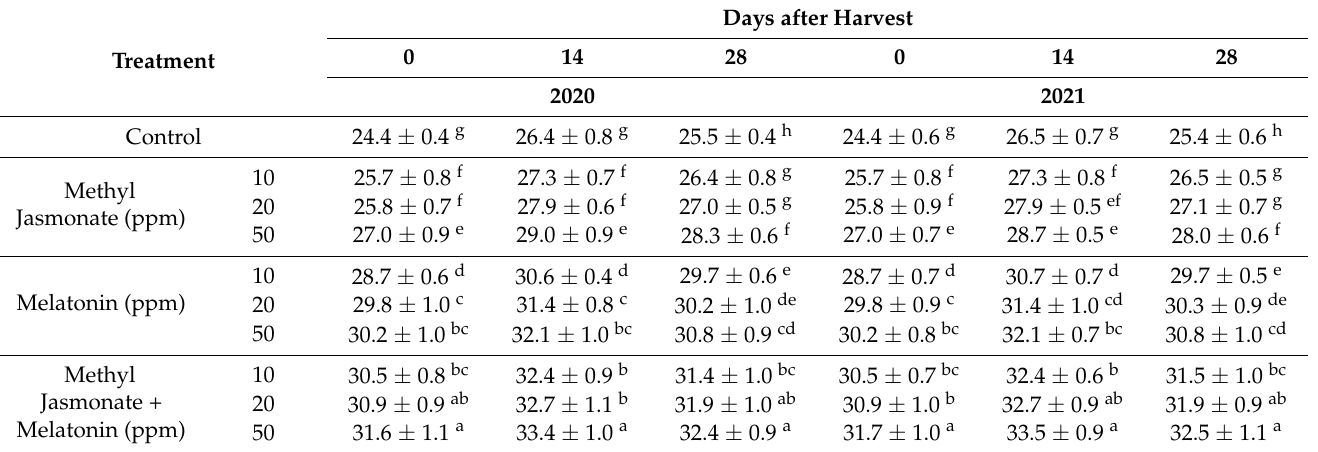
Table 6. Effects of foliar application of melatonin and/or methyl jasmonate solutions at different concentrations on the total sugars content (g/100 g fresh weight) in date palm fruits (cv. Barhi) stored at 4 ◦ C for 28 days